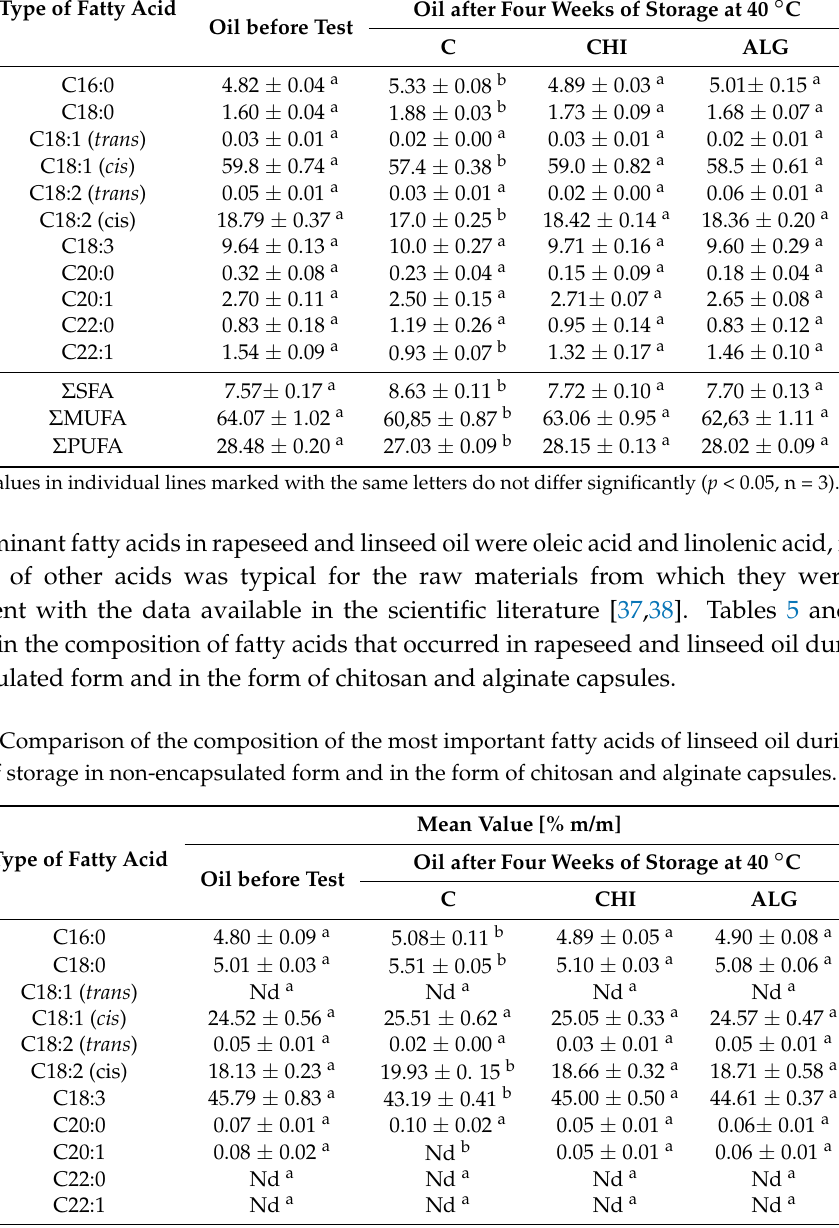
weeks of storage in non-encapsulated form and in the form of chitosan and alginate capsules. Mean Value [% m/m] Type of Fatty Acid Oil after Four Weeks of Storage at 40 ◦ C Oil before Test